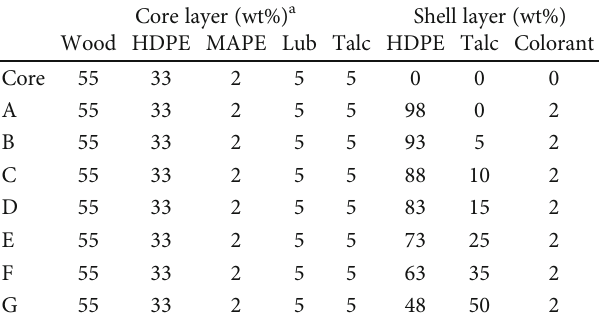
Table 1: Formulation of core-shell (talc- fi lled shell) structured WPC.